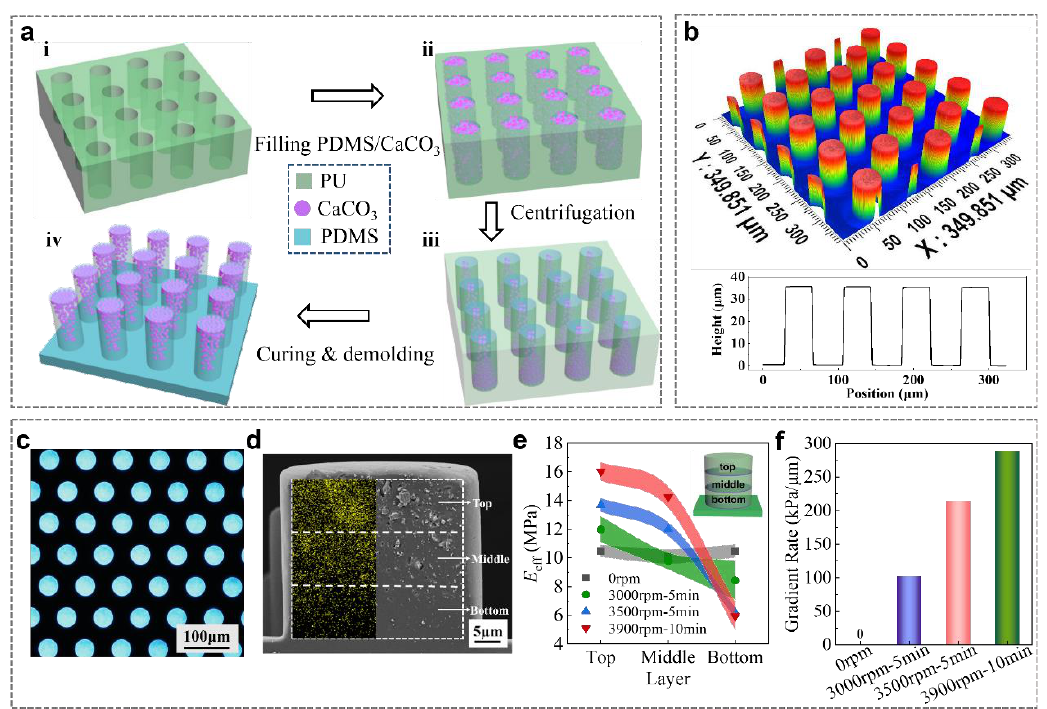
Figure 2. Construction of the GP. ( a ) Schematic of the processing steps for the fabrication of GP: i PU mold with patterned cavities; ii filling the mold cavities with PDMS/CaCO 3 composite and scraping the residual mixtures away; iii redistribution of the nanoparticles to fabricate gradient composite pillars by centrifugation; iv curing and demolding. ( b ) 3D image and height profile of GP array. ( c ) Optical morphology of GP. ( d ) SEM image and EDS map of the cross section of GP. The yellow dots show the distribution of calcium elements (the indication of CaCO 3 ). The micropillar is evenly divided into three layers along the direction of micropillar height. ( e ) E eff of each layer in GP 70wt% under different centrifugal parameters. The inset shows the micropillar is evenly divided into three layers along the direction of micropillar height. ( f ) The gradient rate of GP 70wt% under different centrifugal parameters. Shaded regions in ( e , f ) indicate the standard deviation.